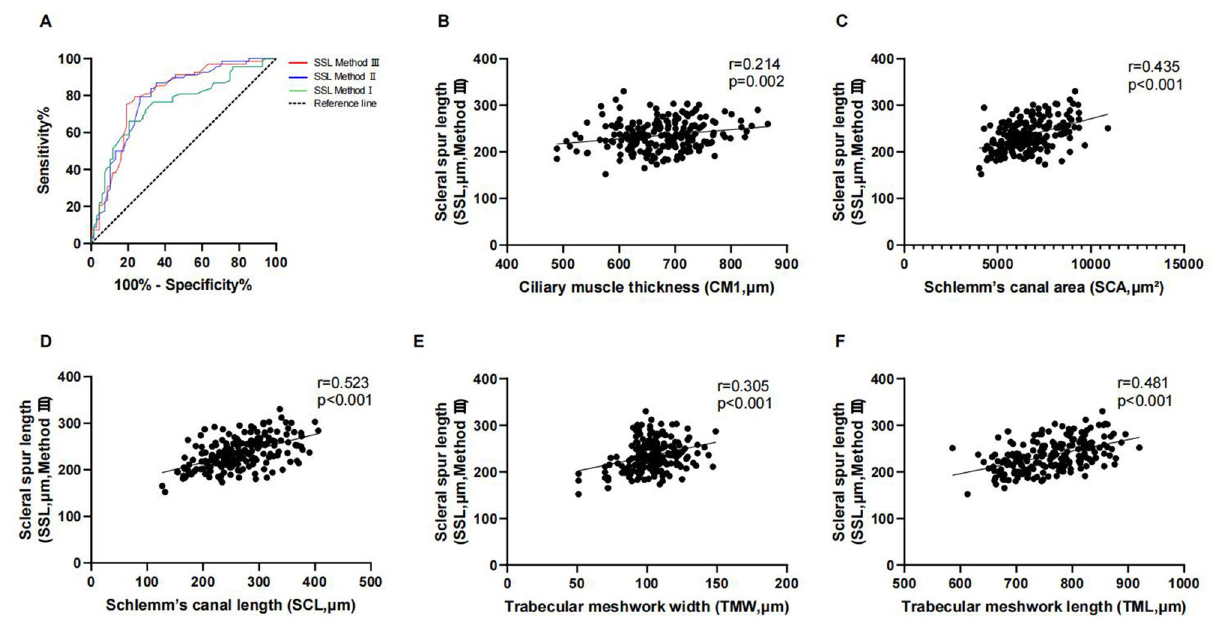
Figure 5. ( A ) Receiver operating characteristic curves for SSL. ( B ) CM1 was significantly correlated with SSL (r = 0.214, p = 0.002). ( C ) SCA was significantly correlated with SSL (r = 0.435, p < 0.001). ( D ) SCL was significantly correlated with SSL. (r = 0.523, p < 0.001). ( E ) TMW was significantly correlated with SSL. (r = 0.305, p < 0.001). ( F ) TML was significantly correlated with SSL (r = 0.481, p <